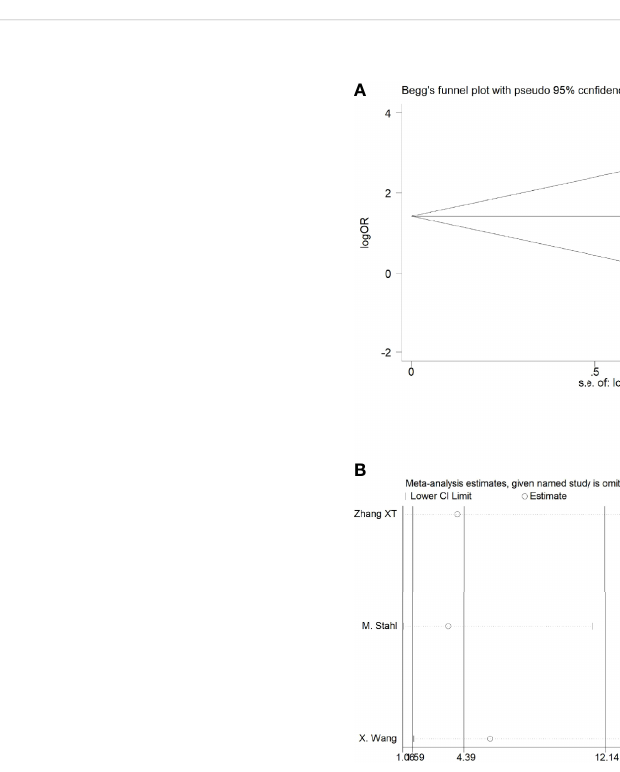
FIGURE 10 Begg ’ s funnel plot (A) and sensitivity analysis (B) of all the included studies for the analysis of ORR.